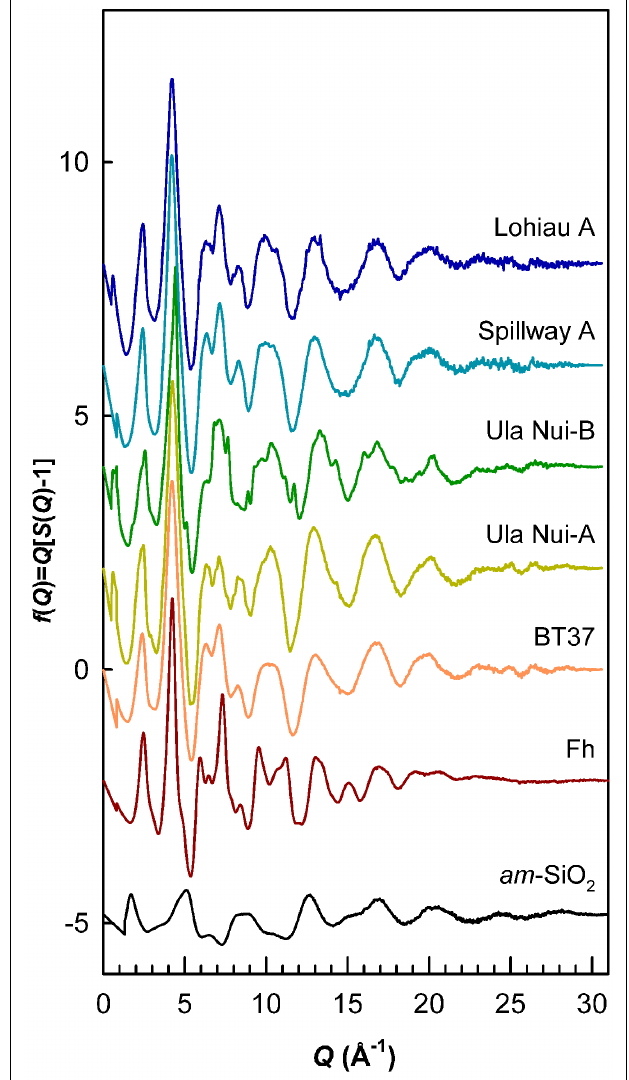
amorphous SiO 2 compared to the five natural samples. Data plotted as f ( Q ) versus Q ( Q = 4 π sin θ / λ ). Overall, the profiles are similar to the Fh reference but differ in terms of peak broadening and the relative intensities of certain features. Sharp features in Ula Nui-B due to birnessite impurity. These data were truncated at maximum Q -range = 30Å − 1 and Fourier transformed with a Lorch modification function to obtain PDFs shown in Figure 5